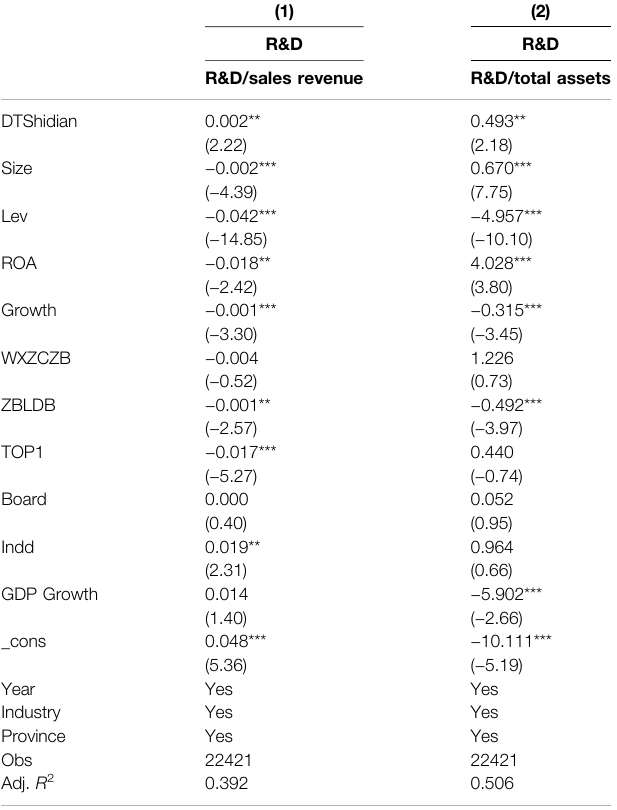
TABLE 5 | The impact of China ’ s pilot low-carbon city initiative on